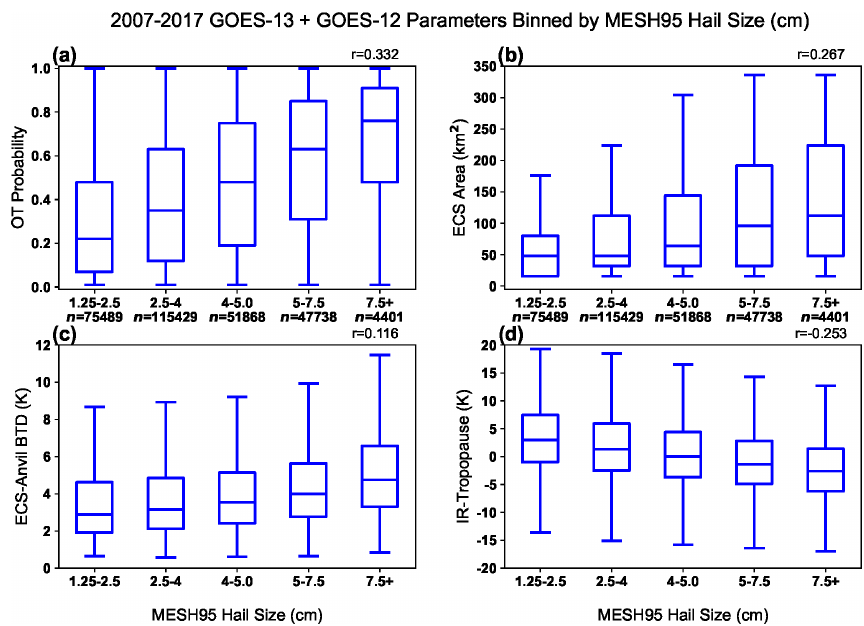
Figure A1. GOES-12 and GOES-13 IR-based parameters binned by MESH95 hail sizes. MESH95 exceeding 4cm is considered a potentially severe storm. Counts in each bin are shown below the x axis, and the Pearson correlation coefficient is shown in the upper right of each